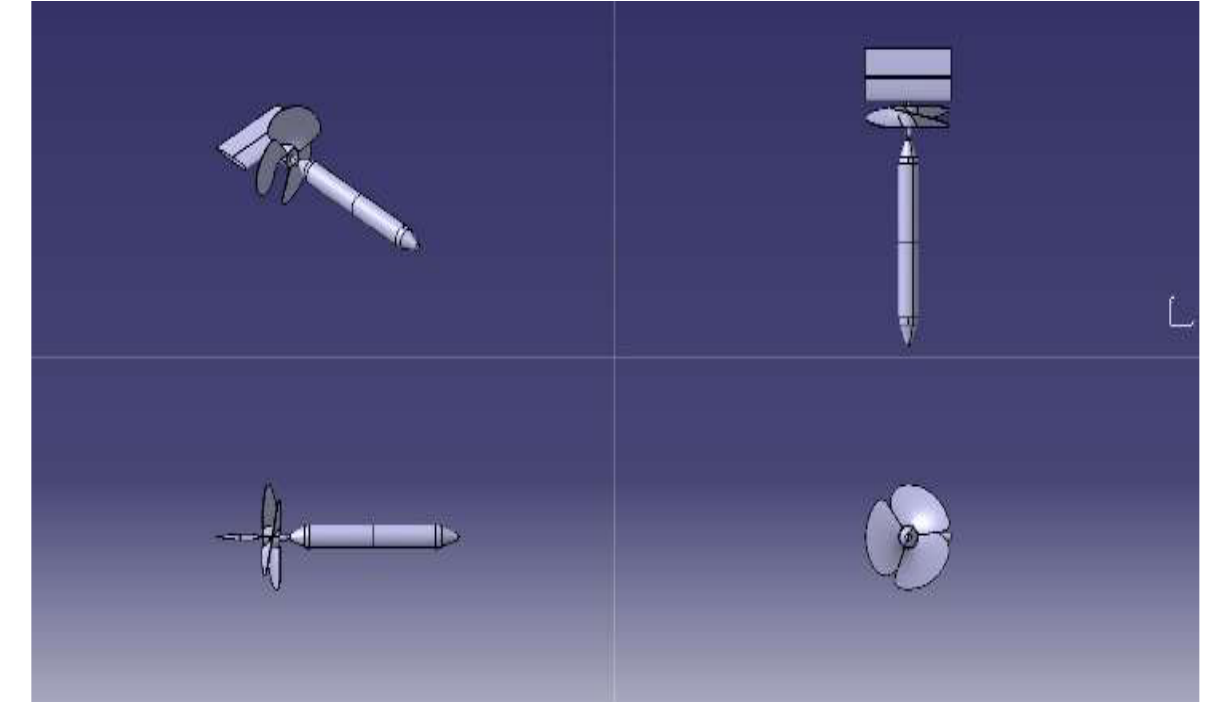
Figure 7. Multi-view of US at steady level flight.